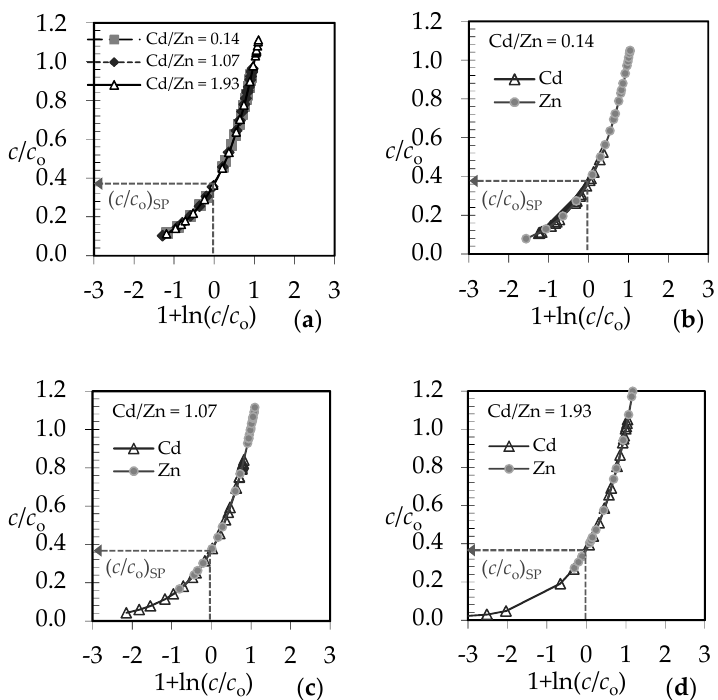
Figure 13. Qualitative evaluation of the rate-controlling step for (Cd + Zn) binary systems at different Cd/Zn ratios: ( a ) for the total (Cd + Zn) concentration; ( b – d ) for each ion in the equimolar (Cd + Zn) system.